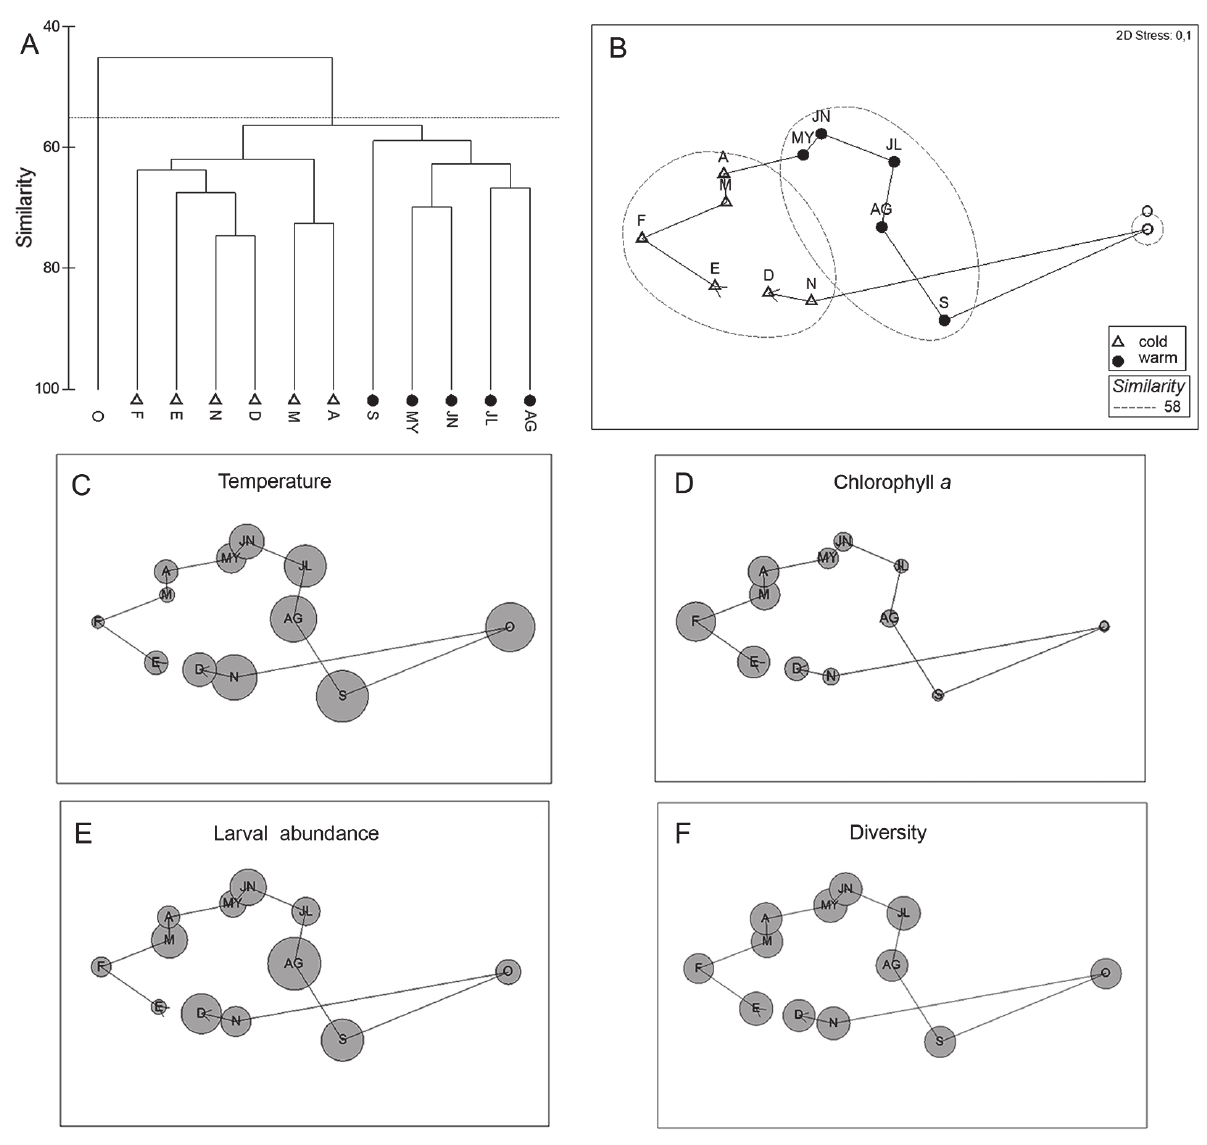
Fig. 5. – Dendrogram showing the classification of months from the Bray-Curtis similarity matrix of monthly averages of decapod larval abundance (A) Non-metric multidimensional scaling (MDS) ordination based on the same similarity matrix. (B) Average temperature, chloro- phyll a , larval abundance and species diversity for each month is superimposed as proportional bubbles over the MDS plot (C-F). Dotted lines separate larval assemblages at the 58% similarity